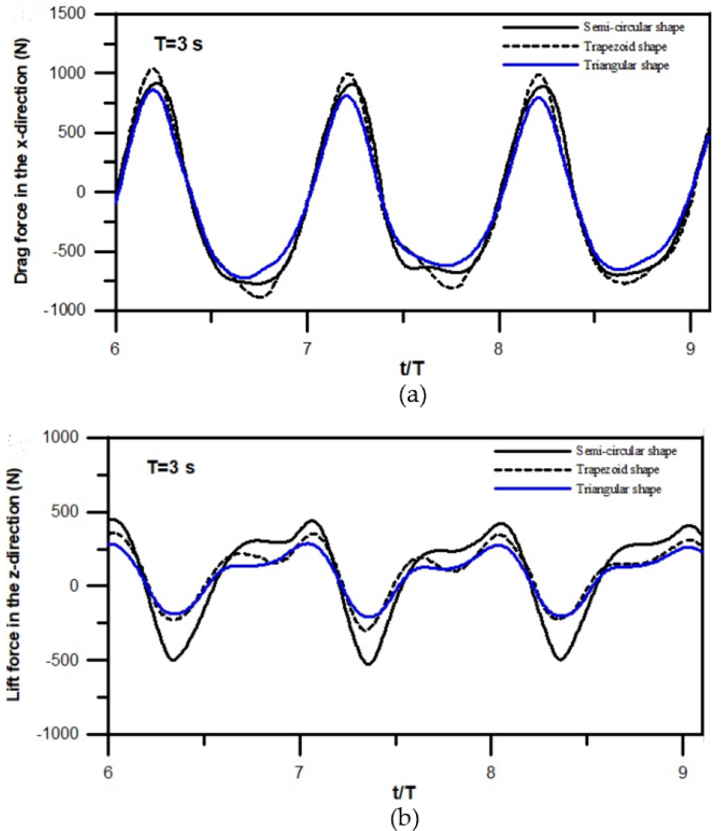
Figure 16. Simulation of the ( a ) drag and ( b ) lift forces for the different configurations of the submerged structures with the incident wave height H i = 0.2 m and T = 3